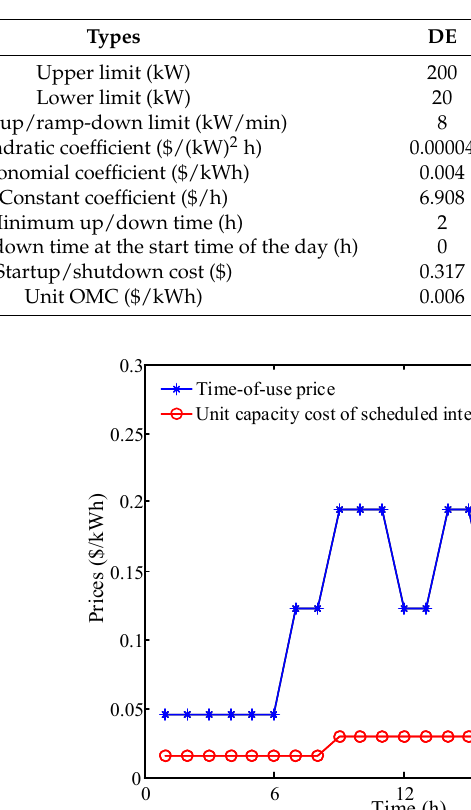
Table 1. Technical and economic parameters of CDG and RES.